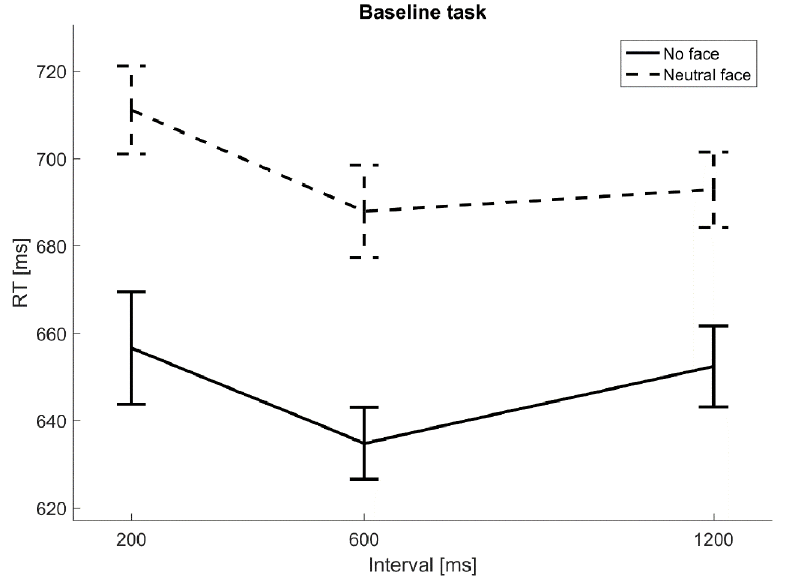
Figure 2a. Reaction times: A. baseline